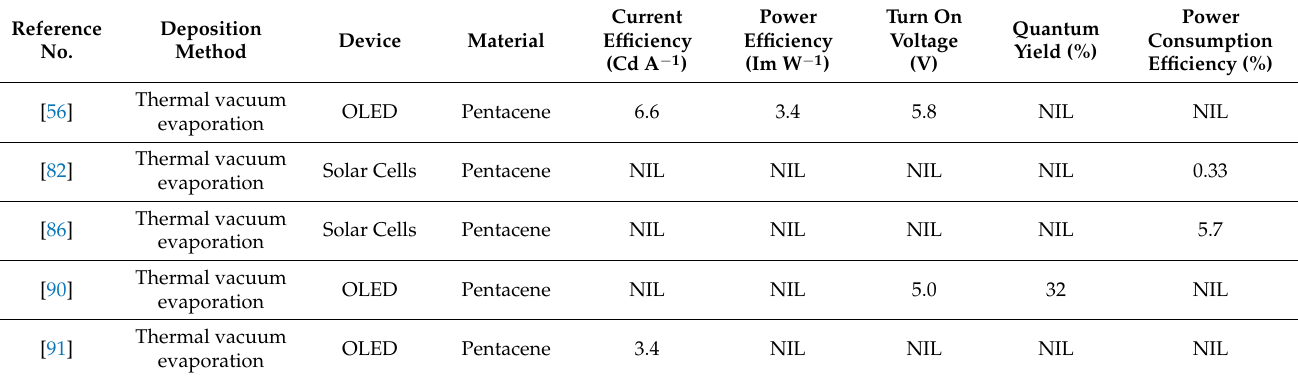
Table 2. Performance comparison of pentacene-based optoelectronic